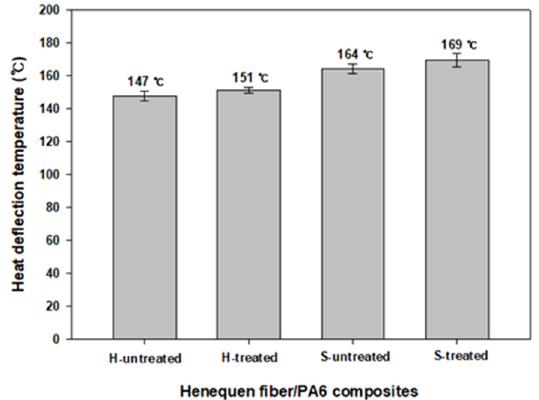
Figure 8. The HDT values measured with untreated or alkali-treated henequen fiber/PA6 composites produced via different fiber feeding routes.